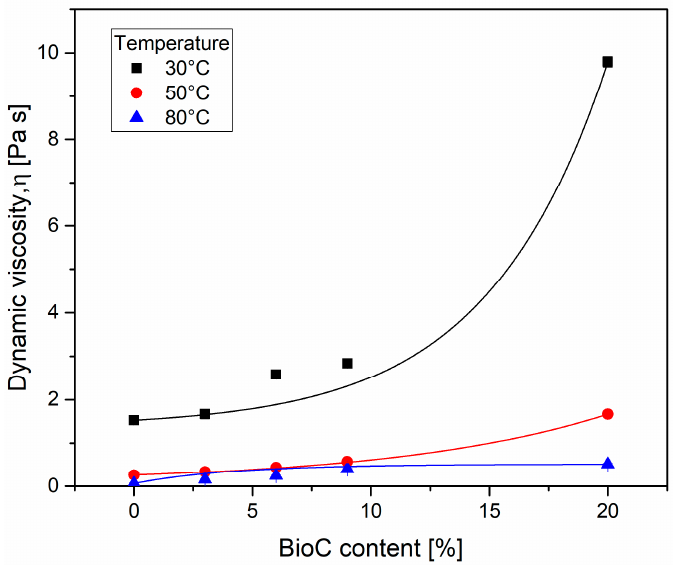
Figure 3. Viscosity of polyol and dispersion of BioC in polyol, measurements at constant shear rate 10 s − 1 .